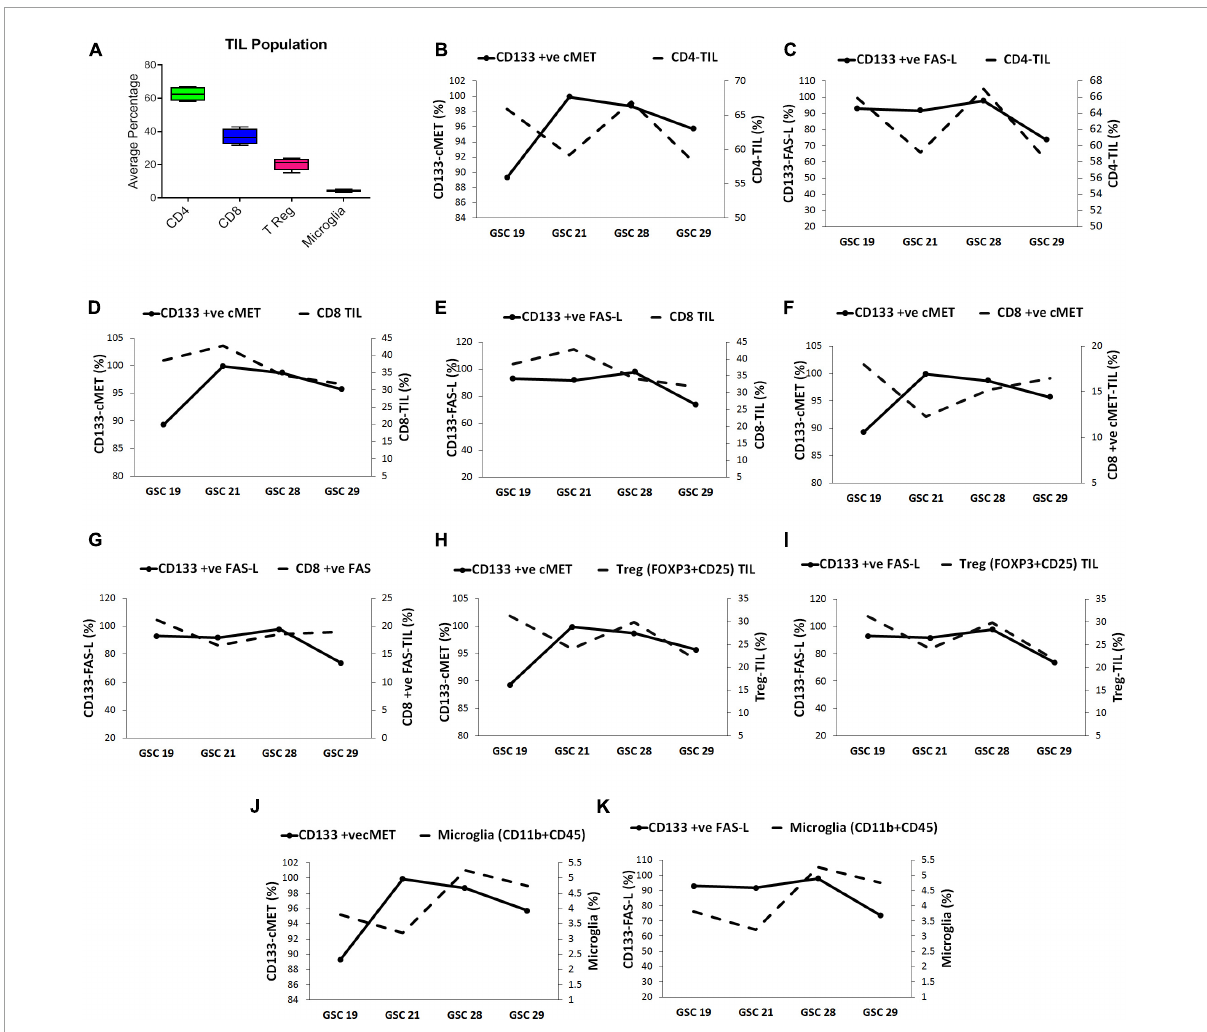
FIGURE2 Glioma stem cells modulate the tumor infiltrating lymphocyte (TIL) population in glioblastoma tumors. (A) The average percentage of immune cell subsets in TILs. The correlation between GSC expressing c-Met and FasL with TIL subset population was evaluated through multivariable plots; (B) CD133 + c-Met-GSCs were inversely related to CD4 + -TIL (C) CD133 + FasL-GSCs were directly related to CD4 + -TIL. (D) CD133 + c-Met-GSCs were directly related to CD8 + -TIL. (E) CD133 + FasL-GSCs were inversely related to CD8 + -TIL. (F) CD133 + c-Met-GSCs were inversely related with CD8 + ve c-Met-TILs. (G) CD133 + FasL-GSCs were directly related to CD8 + ve Fas-TILs. (H) CD133 + c-Met-GSCs were inversely related to T reg-TIL (I) CD133 + FAS-L-GSCs were directly related to T reg-TIL. (J) CD133 + c-Met-GSCs were inversely related to Microglia (K) CD133 + FasL-GSCs were directly related to